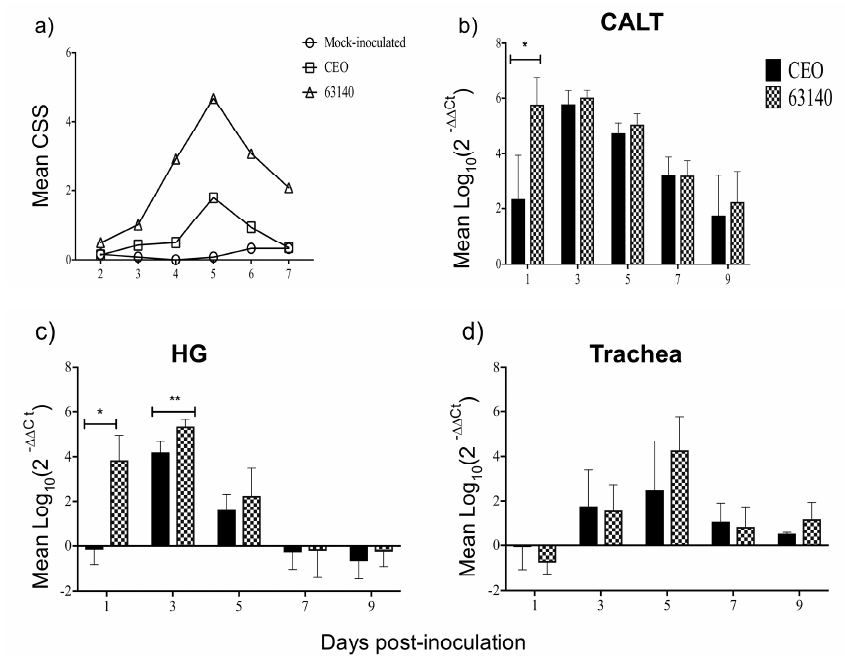
Figure 2. Mean clinical sign scores (CSSs) and mean genome load (Log 10 2 − ∆∆ C t ) of the chicken embryo origin (CEO) vaccine strain and 63140 virulent strain in the conjunctiva-associated lymphoid tissue (CALT), Harderian gland (HG) and trachea. ( a ) Mean clinical sign scores recorded from 2 to 7 dpi ( n = 6 to 7). Mean clinical sign scores are indicated by geometrical symbols. Mean viral genome load in CALT ( b ), HG ( c ), and trachea ( d ) measured at 1, 3, 5, 7 and 9 dpi. The bars represent the mean viral genome load and the vertical lines indicate the standard deviation for each tissue. Significant di ff erences in viral genome load were measured between strains on the basis of the tissue assessed at each time point as are indicated (* p ≤ 0.0332, ** p ≤ 0.0021).